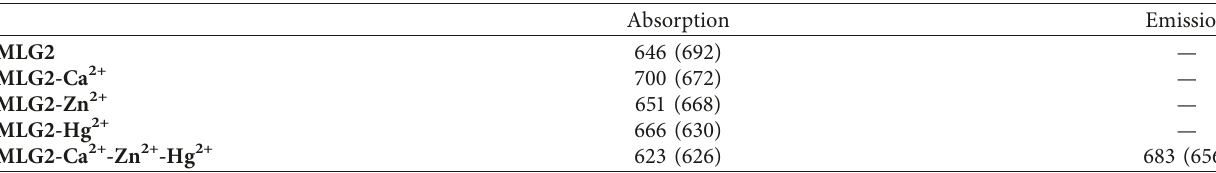
Table 4: Absorption and emission λ max (nm) at the B3LYP level of theory in acetonitrile solvent of uncomplexed MLG2 , of monometallic, and trimetallic complexes of MLG2 in acetonitrile solvent.